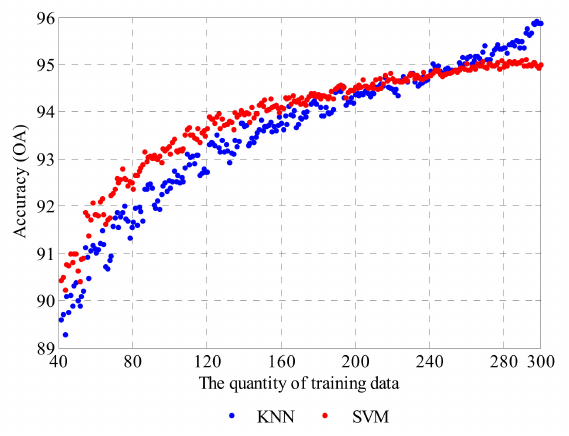
Figure 16. The best accuracy of KNN and